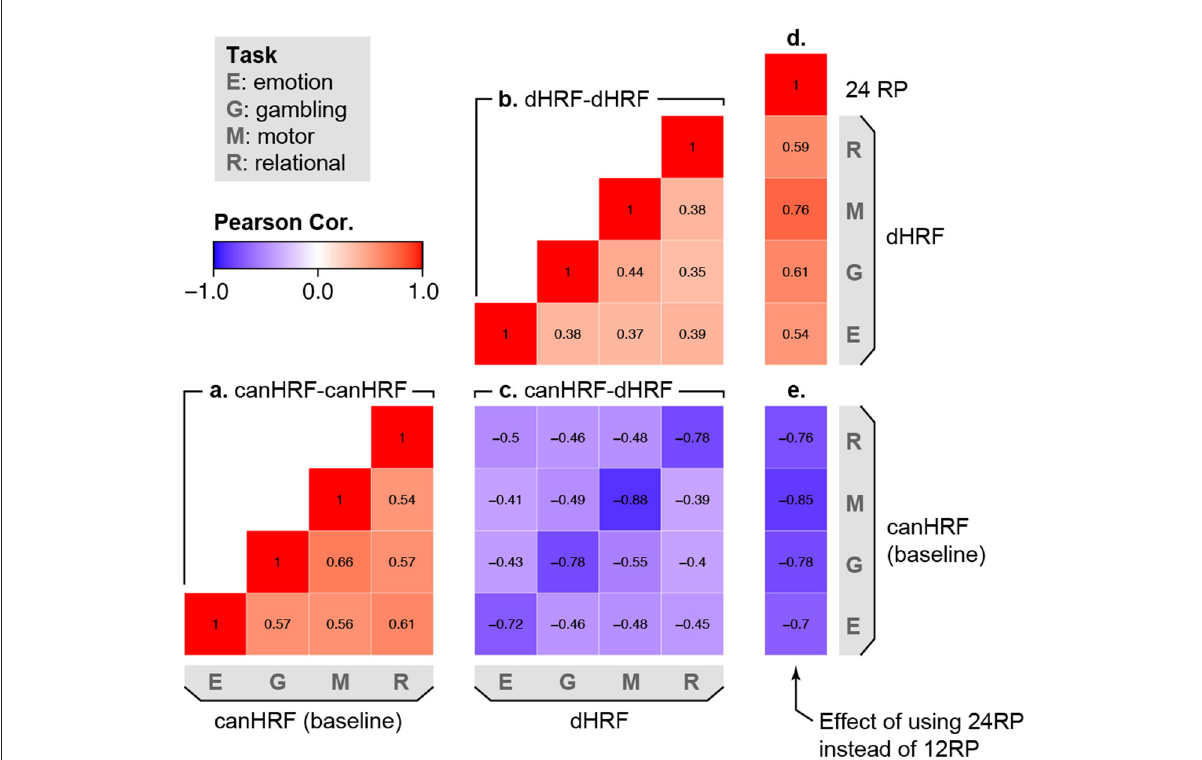
FIGURE5 Correlation among sources of population variability in autocorrelation, based on the random effect (RE) correlations in model (2). Values represent the mean across all vertices. Positive values (warm colors) between two effects indicate that subjects who exhibit higher values in one effect also tend to exhibit higher values in the other effect. Negative values (cool colors) indicate that subjects who exhibit higher values in one effect tend to exhibit lower values in the other effect. The lower triangle of the correlation matrix is divided into several parts, representing the correlation between: (a) different tasks in the baseline level of autocorrelation; (b) different tasks in the effect of HRF derivatives on autocorrelation; (c) the baseline level of autocorrelation and the effect of including HRF derivatives on autocorrelation; (d) the effect of including additional motion regressors and the effect of including HRF derivatives; (e) the effect of including additional motion regressors and the baseline level of autocorrelation.